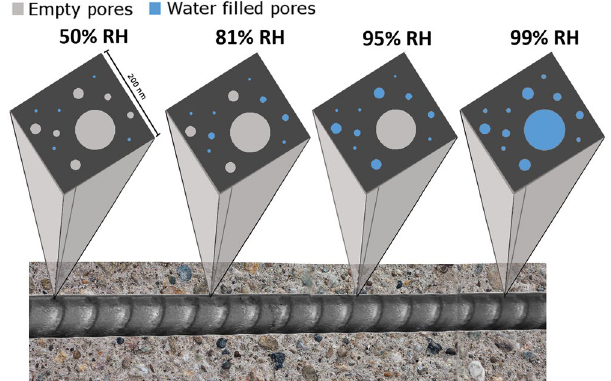
Figure 4. Graphical representation of the changing steel surface area in contact with water. As a consequence of water condensation in pores at different relative humidity, the steel area on which corrosion can take place varies nonlinearly with the